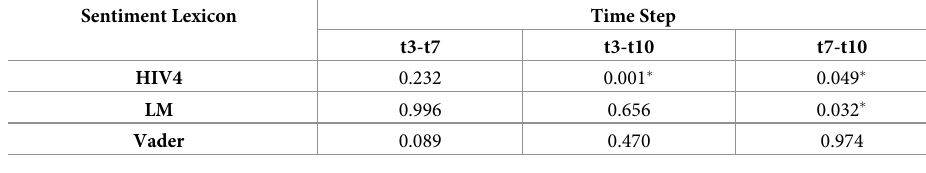
Table 8. p-values for the third hypothesis test.